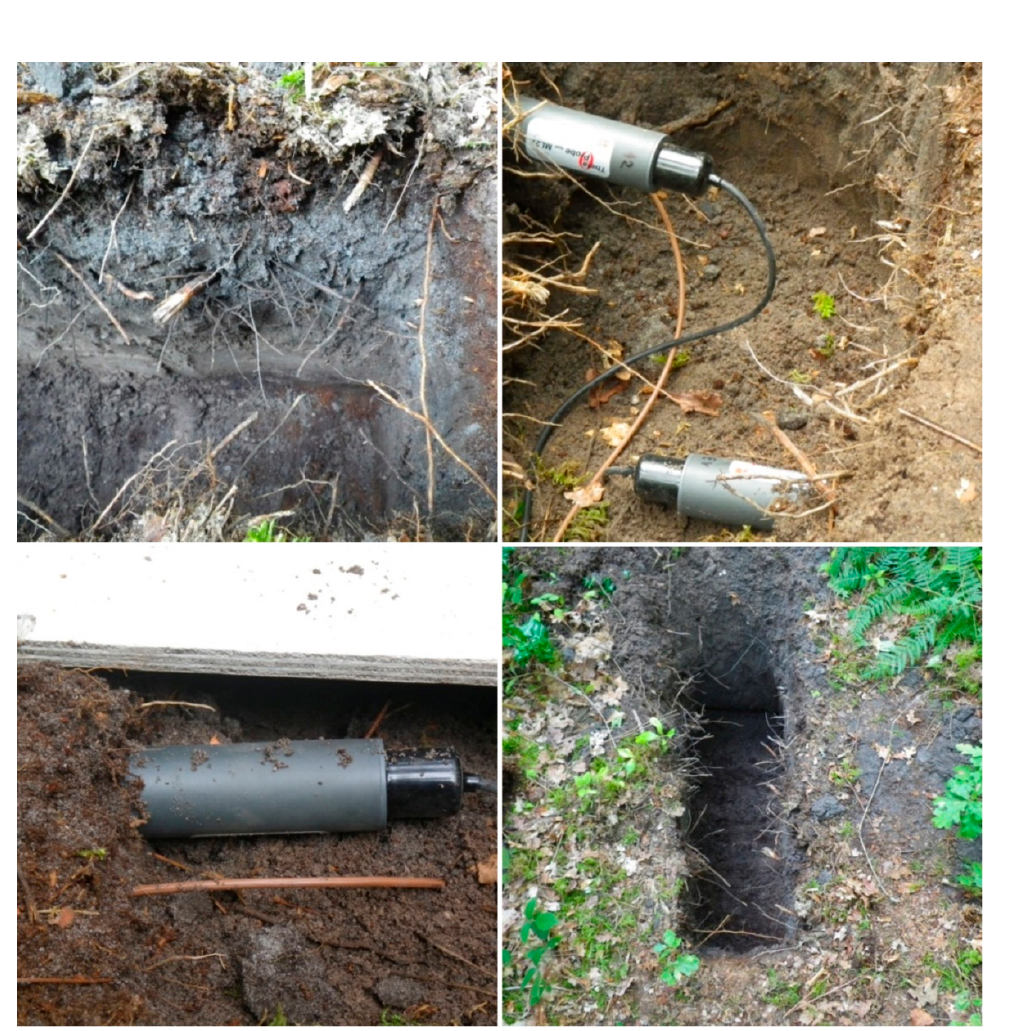
Figure 2. Installation of the soil moisture sensors at FRAYE site.